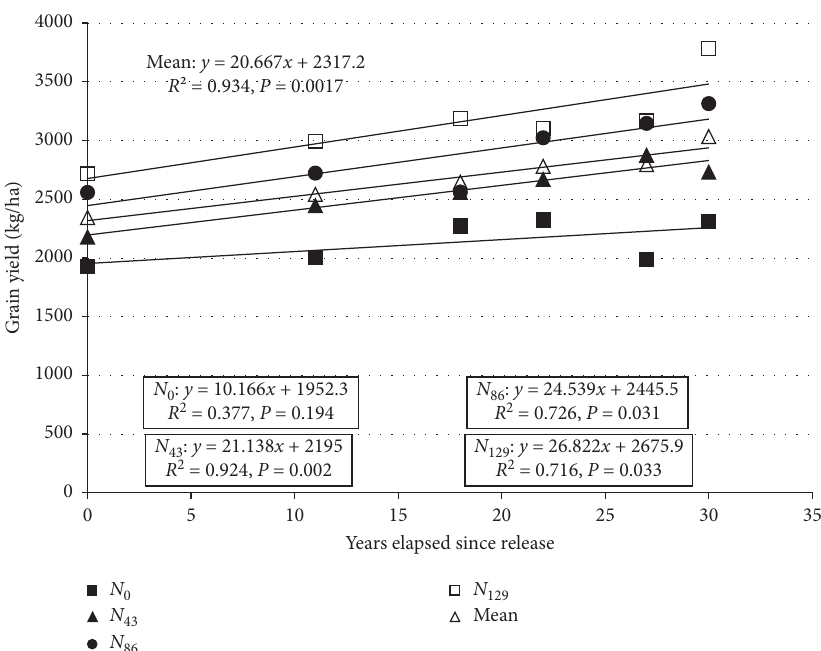
Figure 4: Relationship of grain yield (kg ha − 1 ) of six bread wheat cultivars released between 1960 and 1990 and grown at four N levels with the time elapsed since their year of